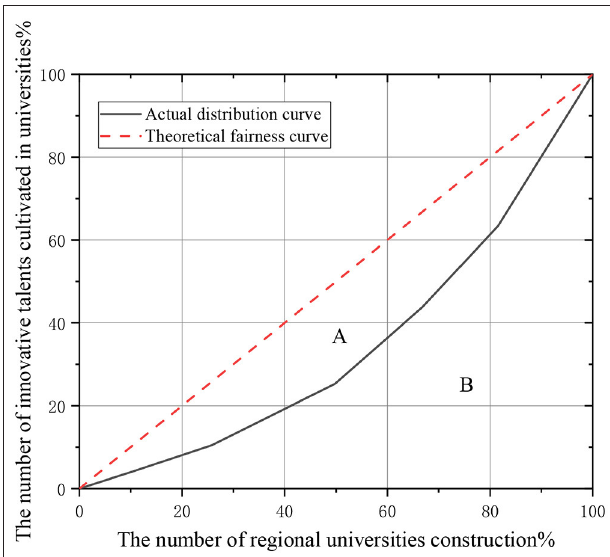
FIGURE 3 | Lorenz curve analysis of educational resources and talent cultivation in